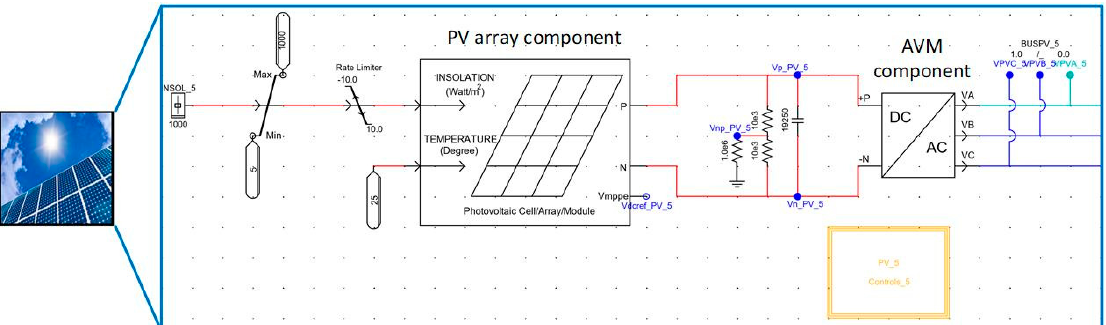
Figure 5. Voltage regulator used for constructing the distribution system.